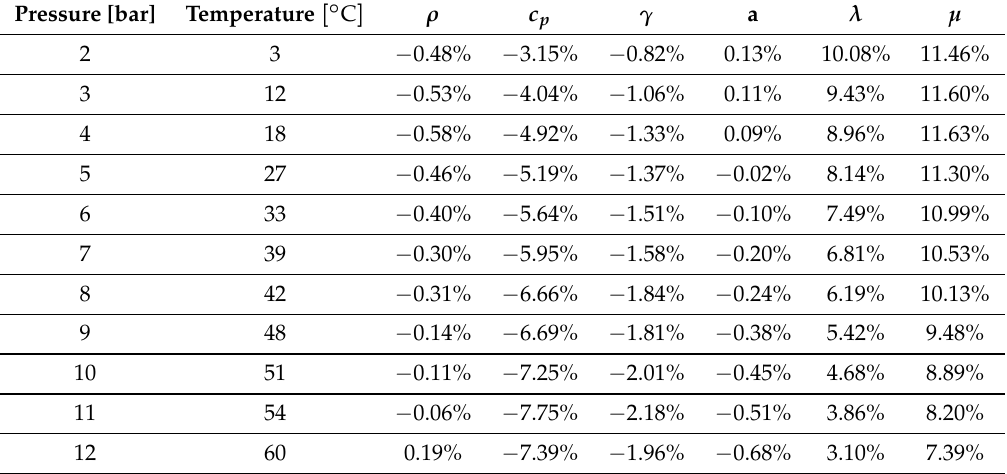
Table 1. Relative error for Peng–Robinson and related